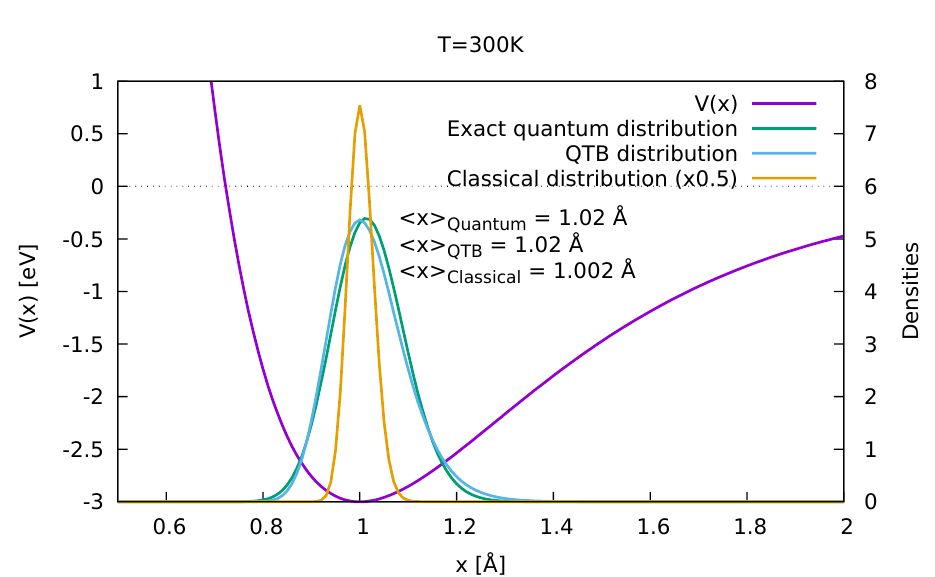
Figure 3. A ‘mildly’ anharmonic Morse potential (magenta, left-hand scale), with the position distributions (right-hand scale) for a classical simulation (yellow), a quantum solution through Schrödinger’s equation (green) and the Quantum Thermal Bath (light